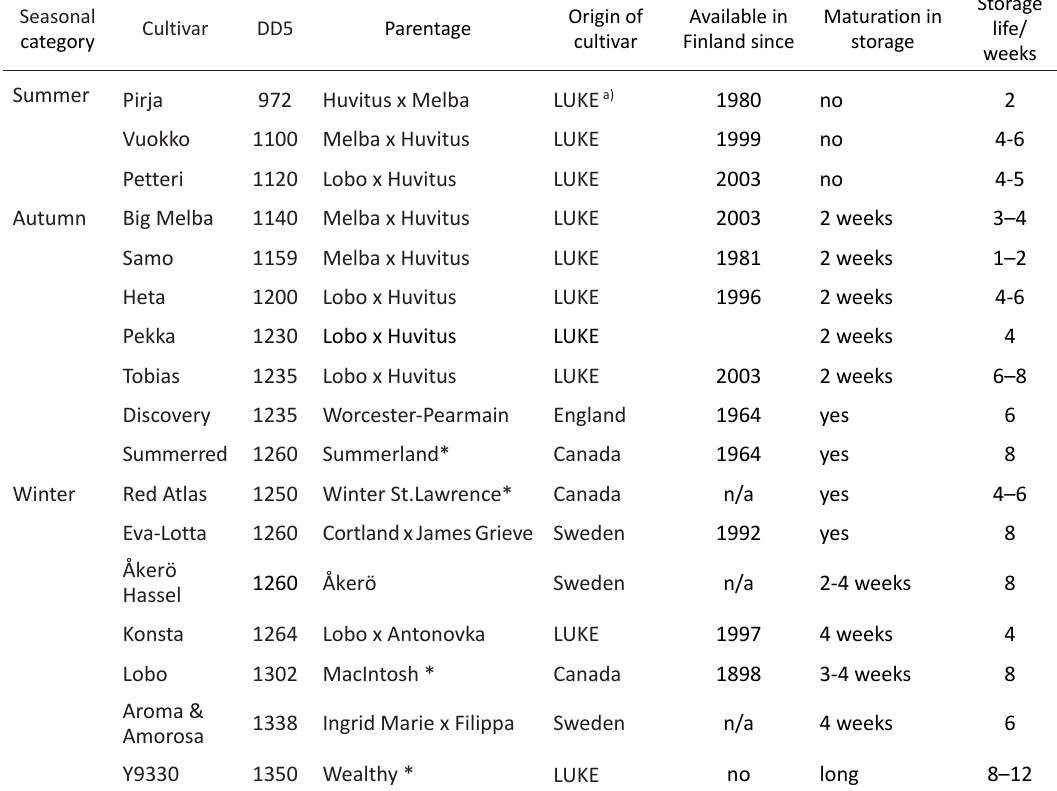
Table 1. Apple cultivars included in the study with their breed, characteristics and DD5, the requirement for cumulative base temperature over 5°C during growing season (Tahvonen 2007, Krannila and Paalo 2008) Seasonal category